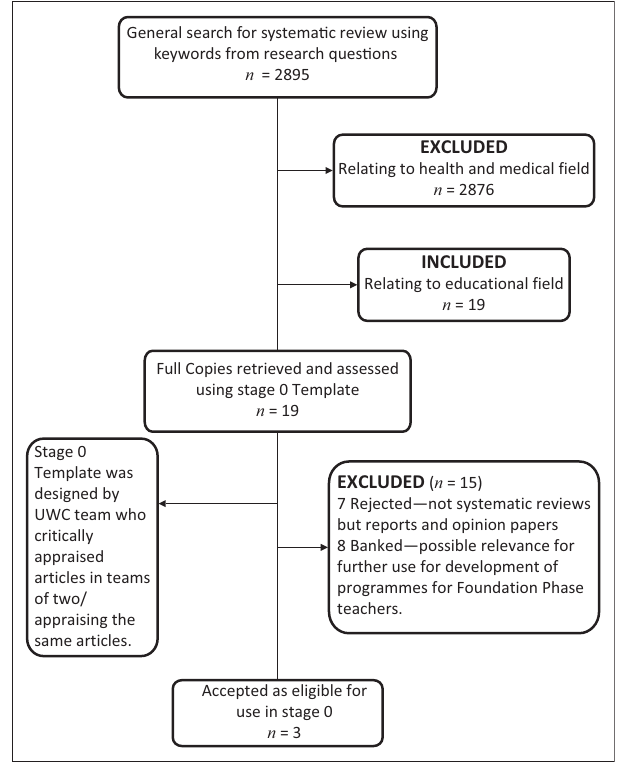
FIGURE 1: Flow chart of selection process for Stage